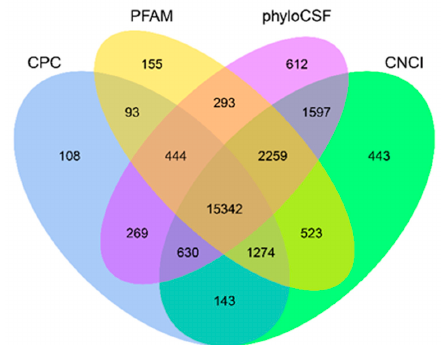
Figure 1. Screening of the candidate long non-coding RNAs (lncRNAs) in placenta transcriptome. Coding Potential Calculator (CPC), Coding-Non-Coding-Index (CNCI), Pfam-scan (PFAM) and phylogenetic codon substitution frequency (phyloCSF) were used to analyze the coding potential of lncRNAs. CPC, Coding Potential Calculator; PFAM, Pfamscan; PhyloCSF, phylogenetic codon substitution frequency; CNCI, Coding-Non-Coding-Index.